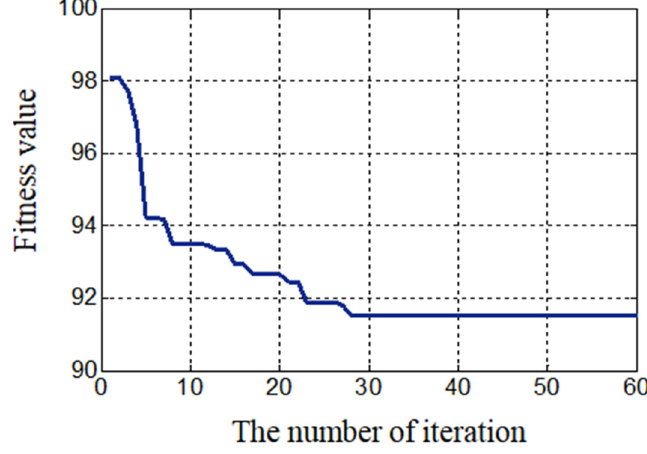
Figure 14. Convergence curve of the objective function.